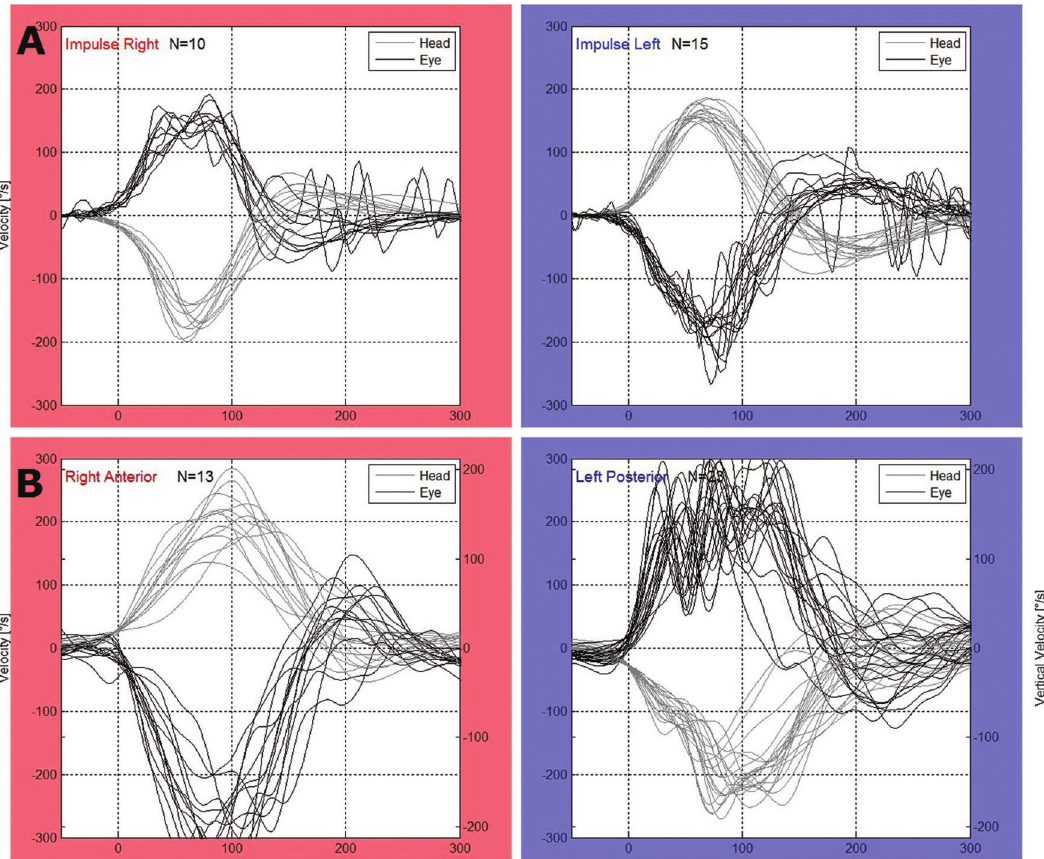
Figure 1 - vHIT chart. A: normal test, B: velocity decay, low gain and corrective saccades on the left side (see Cam vHIT Interacoustics).